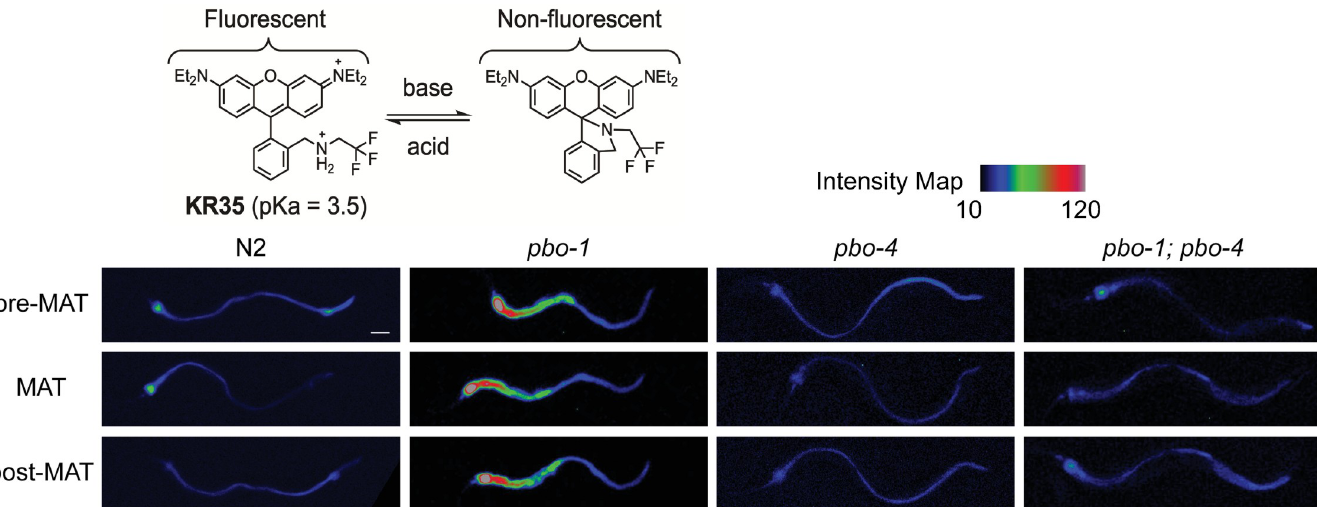
Fig 1. pbo-1 mutations disrupt the intestinal acid wave. The chemical structures of KR35 under acidic and basic conditions are shown. The protonated ring-opened form is highly fluorescent, and the deprotonated spirocyclic form is non-fluorescent. The intensity map provides the lookup table values for the pixel intensity in each image. Fluorescence micrographs of C . elegans wild type or pbo mutants after feeding on the pH-sensitive probe KR35 for 30 min (10 μ M). Time-dependent images during the DMP extracted from video microscopy are shown. Fluorescence is rendered as a heat map of fluorescence intensity with red representing the most intense fluorescence (high acidity), and black the least intense fluorescence (low acidity). The head of the animal is on the left side of each image (scale bar = 50 μ m).